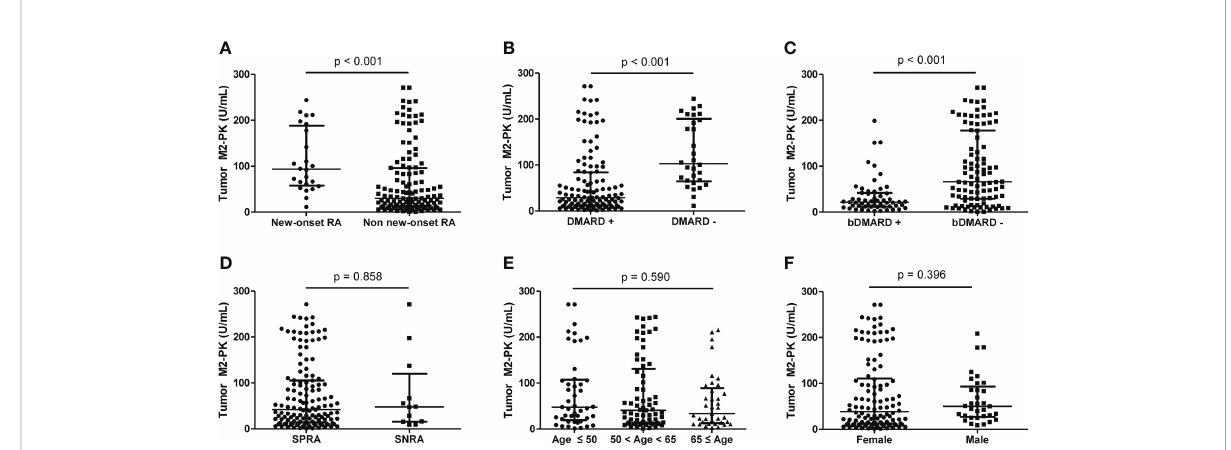
FIGURE 4 Comparison of tumour M2-PK level based on disease duration, DMARD usage, seropositivity, age, and sex. The differences in tumour M2-PK levels were assessed in RA patients with regard to (A) disease duration, (B) DMARD usage, (C) bDMARD usage, (D) serotype, (E) age, and (F) sex. Mann – Whitney U test and Kruskal – Wallis test was used for the comparison of two groups, and three groups, respectively. The error bars indicate median values and interquartile range. Tumour M2-PK, dimeric form of pyruvate kinase M2; DMARD, disease-modifying anti-rheumatic drug; bDMARD, biologic disease-modifying anti-rheumatic drug; SPRA, seropositive rheumatoid arthritis; SNRA, seronegative rheumatoid